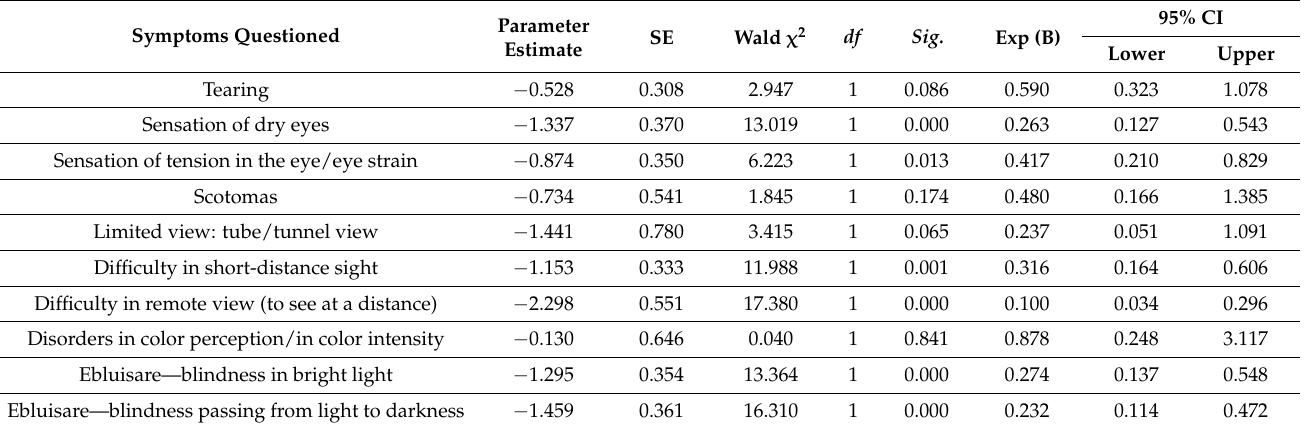
Table 13. Distribution of binomial logistic regression parameters to the symptom questionnaire in the POAG and NG patients.